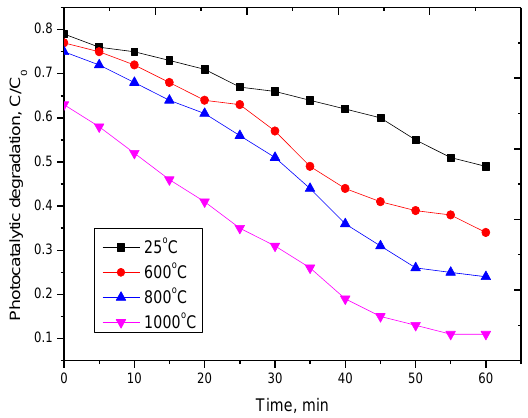
Figure 6. Dynamics of changes in the photocatalytic degradation of methyl orange on nanostructures, where C 0 is the concentration of methyl orange in an aqueous solution of 25 mg / L, C is the concentration of methyl orange after irradiation with UV radiation.